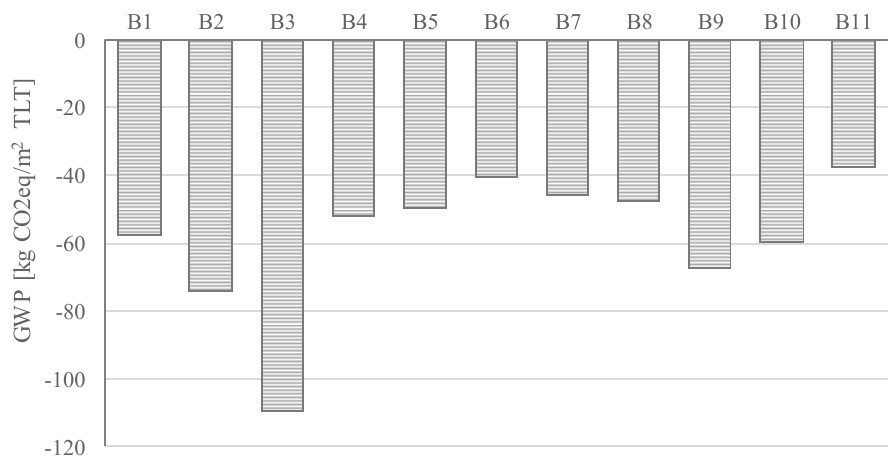
Figure 5. Potential benefits beyond the assessed system boundary.